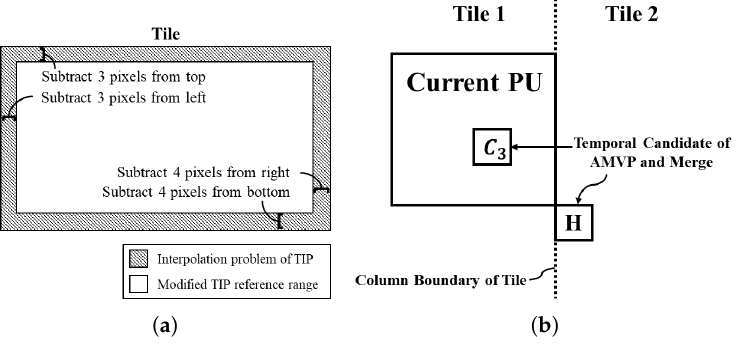
Figure 10. Tile Extractor Implementation Problems with ( a ) Interpolation problem of referring to a tile at the same position in the TIP, ( b ) Temporal candidate problem at column boundary between